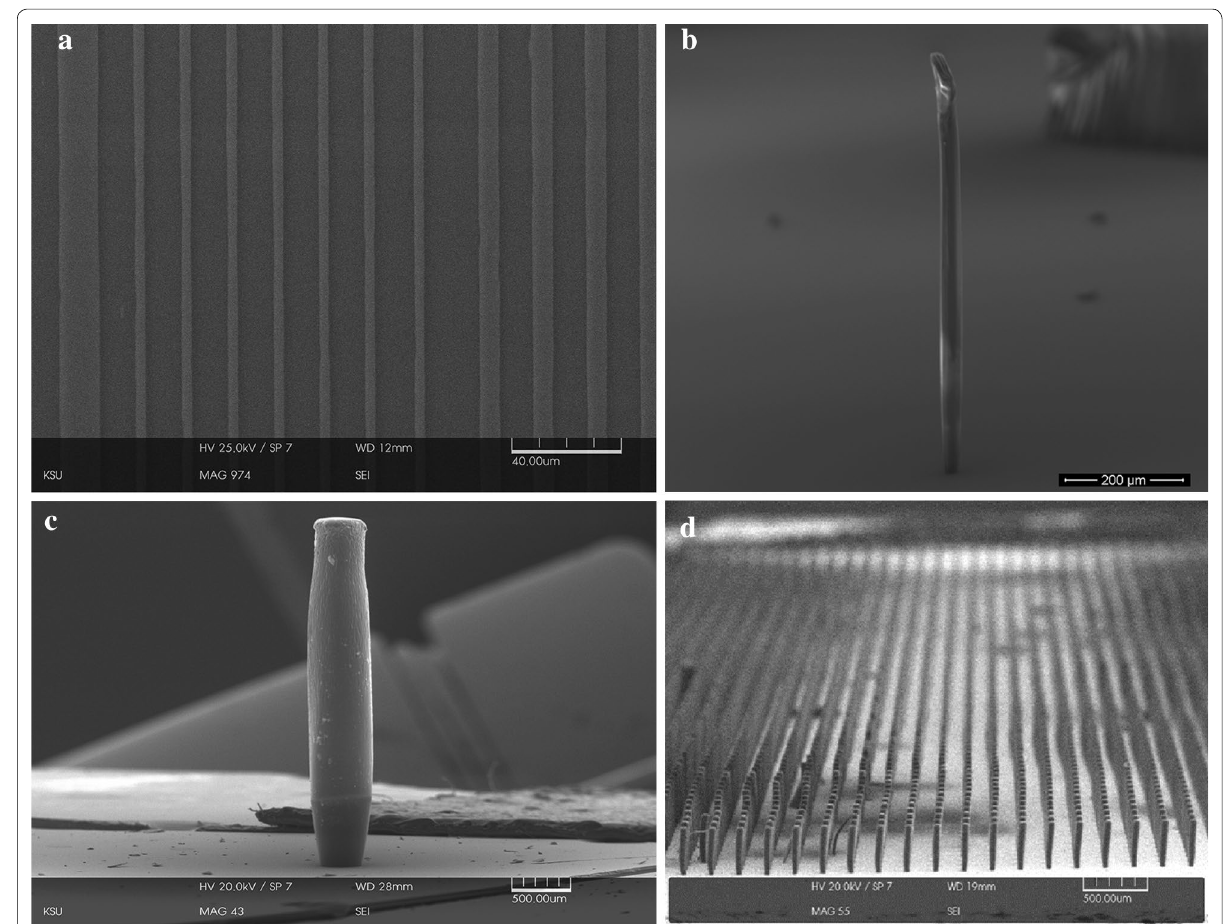
Fig. 10 Small feature size, and high aspect ratio pillar, millimeter tall high aspect ratio pillar: a 3.5 and 8 micron lines, b high aspect ratio micropillar, c 3-mm tall micropillar, d more than 2000 micropillar